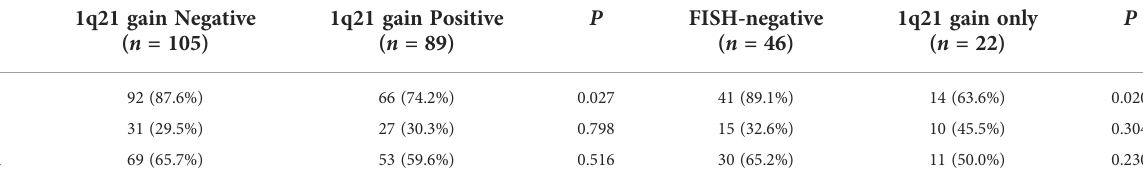
TABLE 4 Treatment response